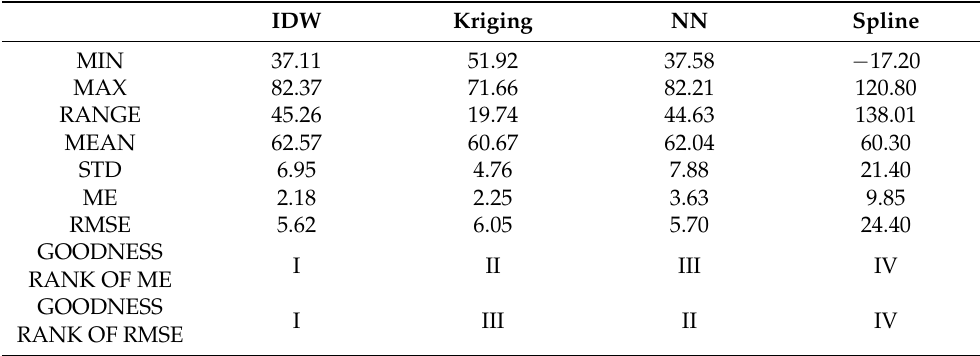
Table 3. Statistical overview of the air pollution model interpolation errors (with measured sample values minus interpolated ( µ g /m 3